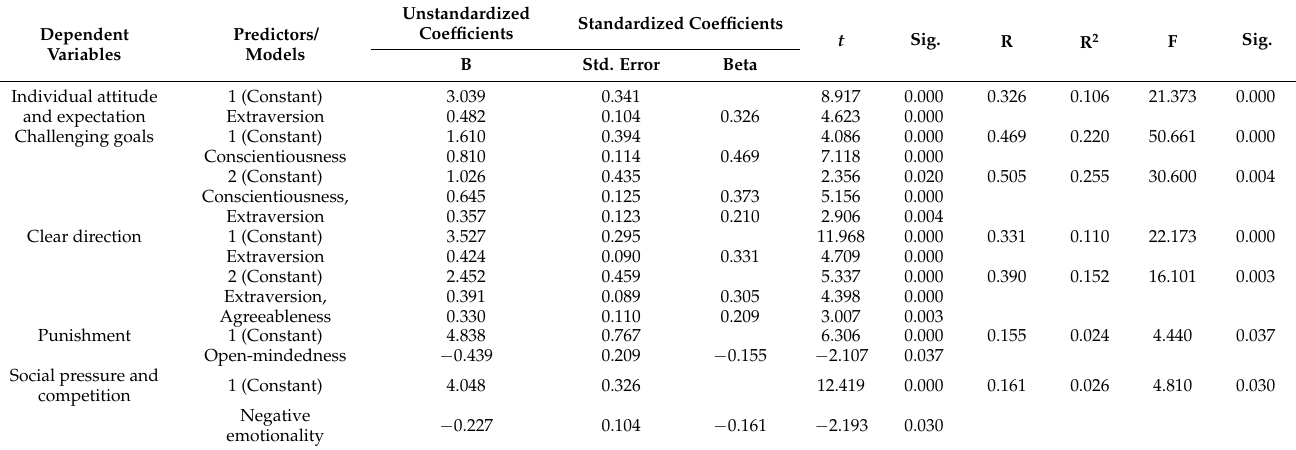
Table 7. Multiple linear regression models in the group of computer programming e-learners, the dependent variables are learning motivating factors, and the predictors are personality traits. Dependent Variables Individual attitude and